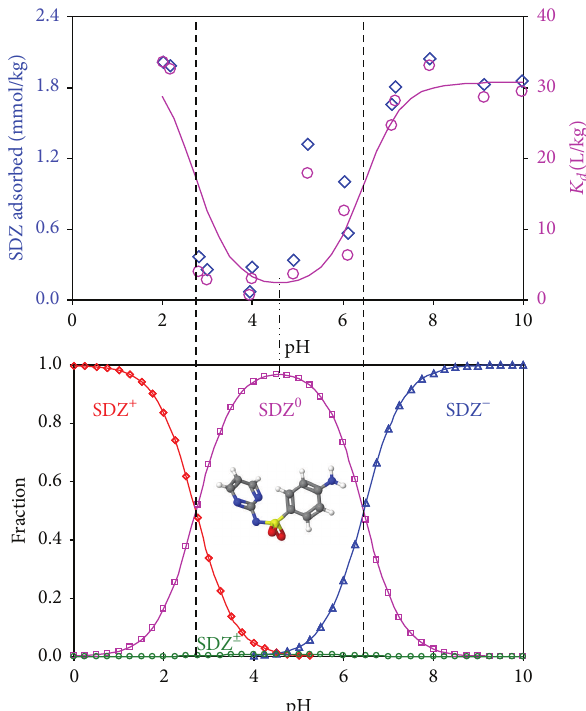
Figure 5: SDZ adsorption on zeolite as affected by equilibrium solution pH ( ◊ with left 𝑦 -axis) and 𝐾 𝑑 as affected by solution pH ( ◻ right 𝑦 -axis). The solid line is the fitted 𝐾 𝑑 as a function of pH.